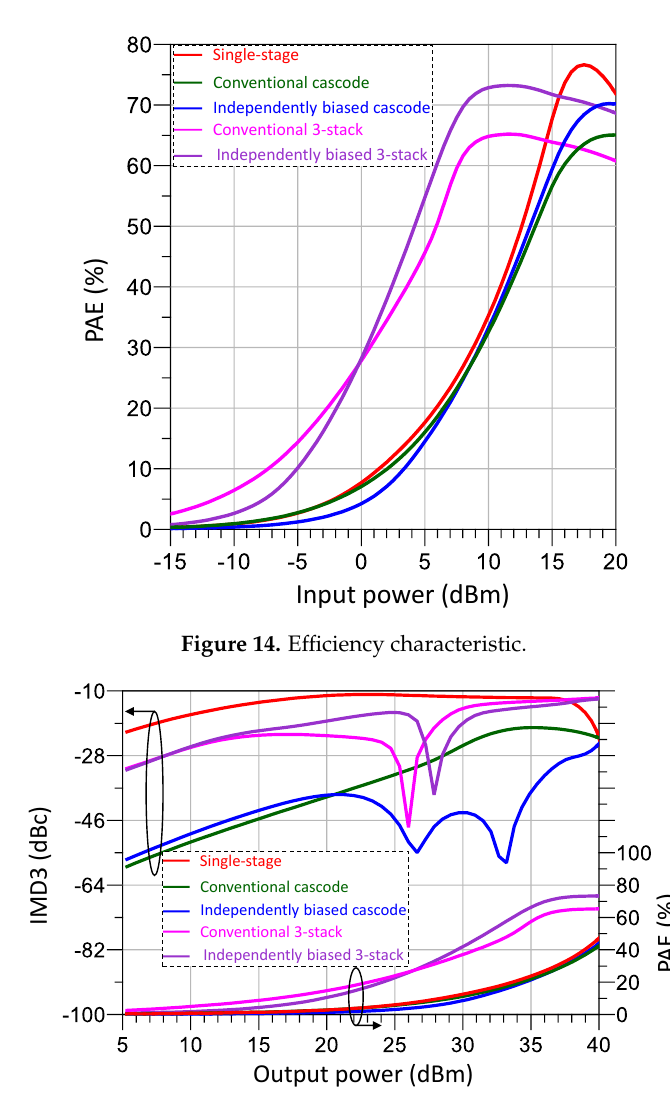
Figure 15. Linearity (IMD3) characteristic.